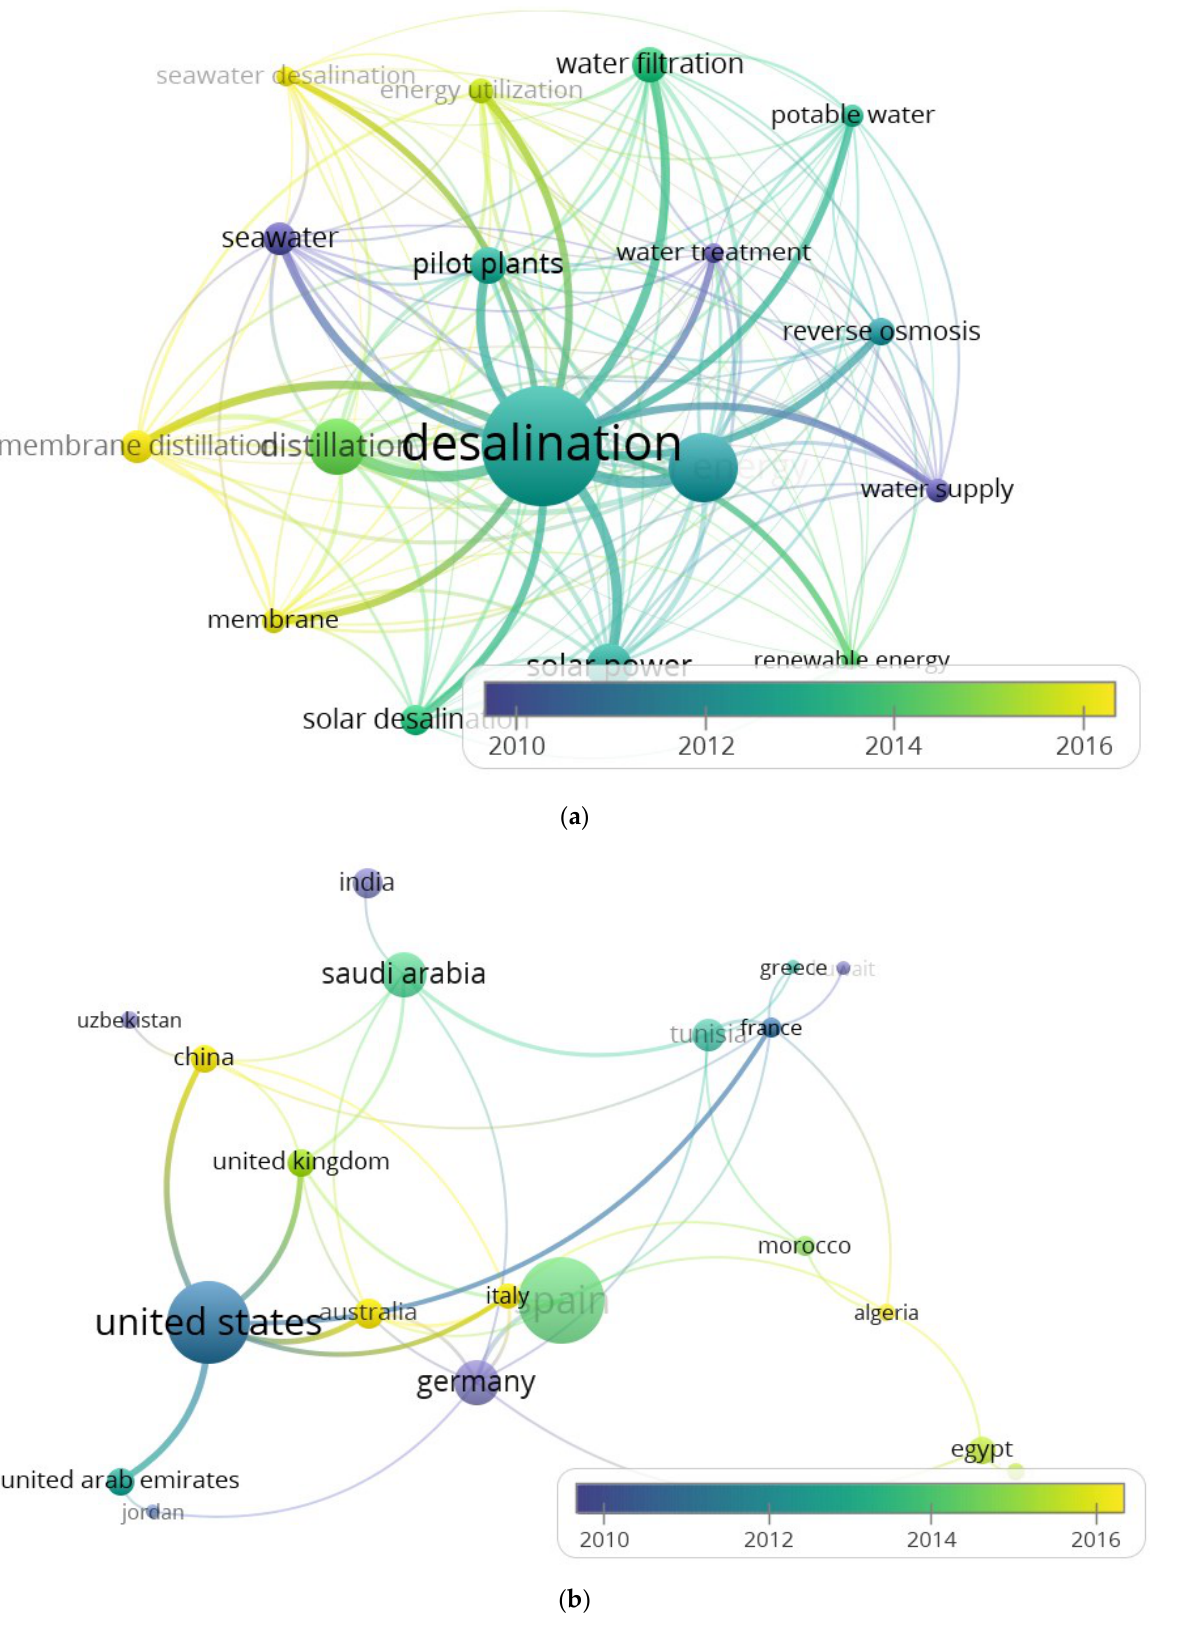
Figure 1. Results of the bibliography analysis based on ( a ) keywords and ( b ) country contributions.